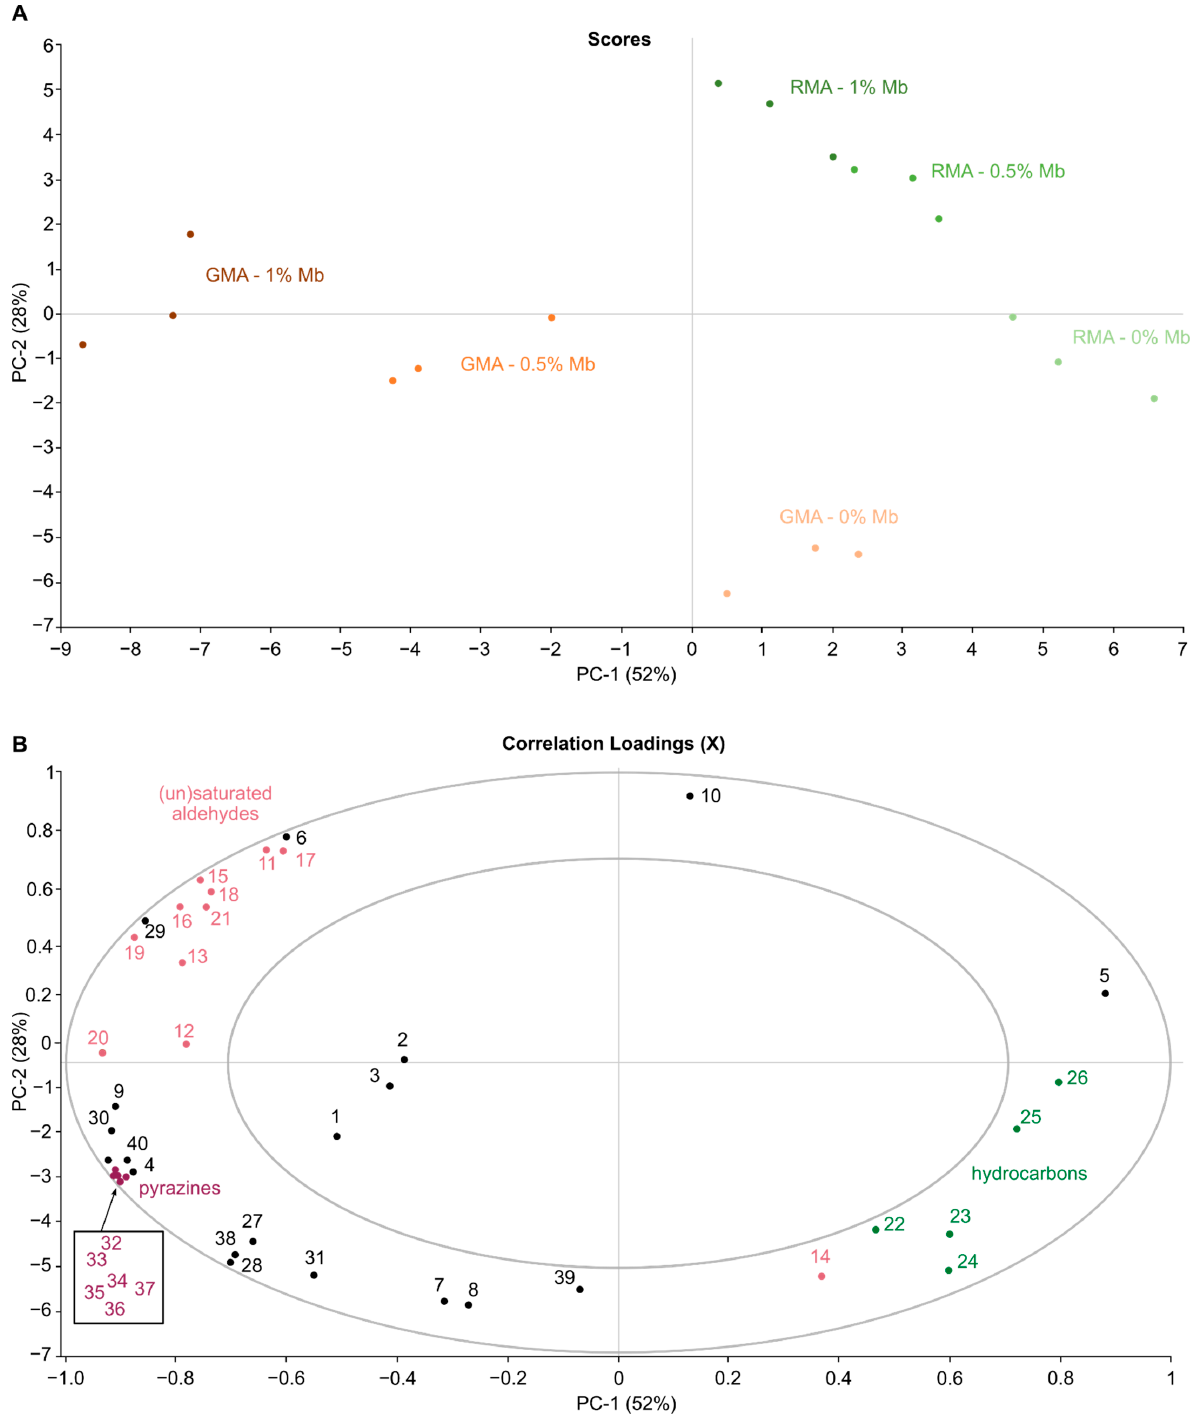
Figure 1. PCA scores ( A ) and correlation loadings ( B ) plots of PC1 and PC2 for volatile compounds in raw and grilled plant-based burgers enriched with varying concentrations of myoglobin. Volatiles (loadings) are denoted by their numbers in Table 1 [Acids (1–3), Aldehydes (7–21), Hydrocarbons (22–27), Pyrazines (32–37)].